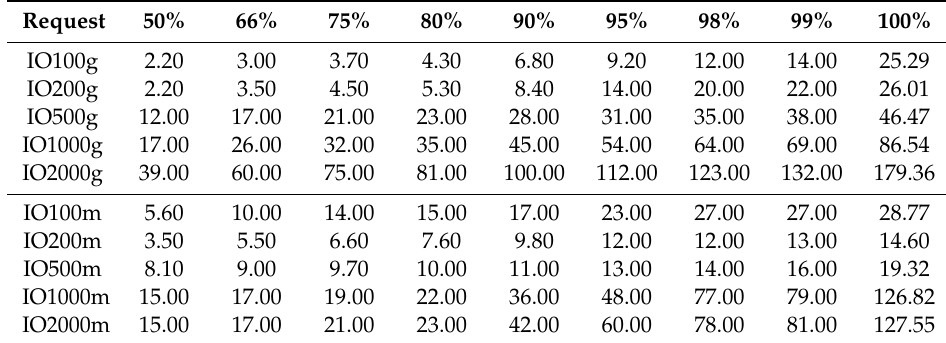
Table 11. Percentage of insertObservation requests completed within given times (in seconds) for the di ff erent configuration of concurrent users and WSGI server (case B).